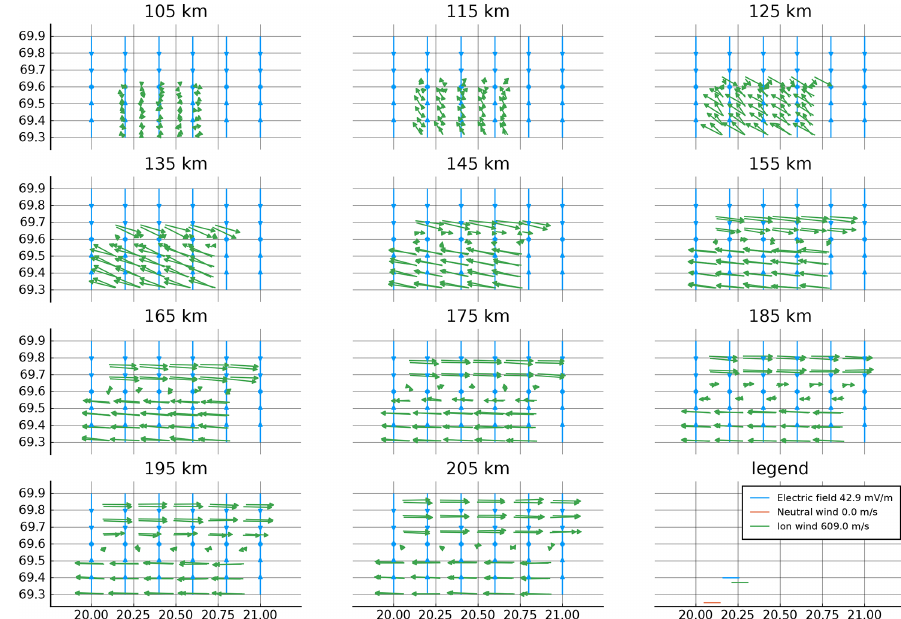
Figure 10. Electric field (blue) and neutral wind (red) used for simulations. Simulated ion wind measurements (green) are also shown. Because the neutral wind is set to zero, it is not seen in the plot. The vertical spacing in the plot is chosen so that the first plot covers our model and measurements between the 100 and 110km range along the magnetic field, the second between 110 and 120km, and so on. Since there are measurements every 5km, each subplot contains two sets of measurements. For example, the 105km plot contains the measurements from the line-of-sight ranges of 100 and 105km. The plots for the uppermost and lowermost ranges look similar to their neighboring range and are not plotted.